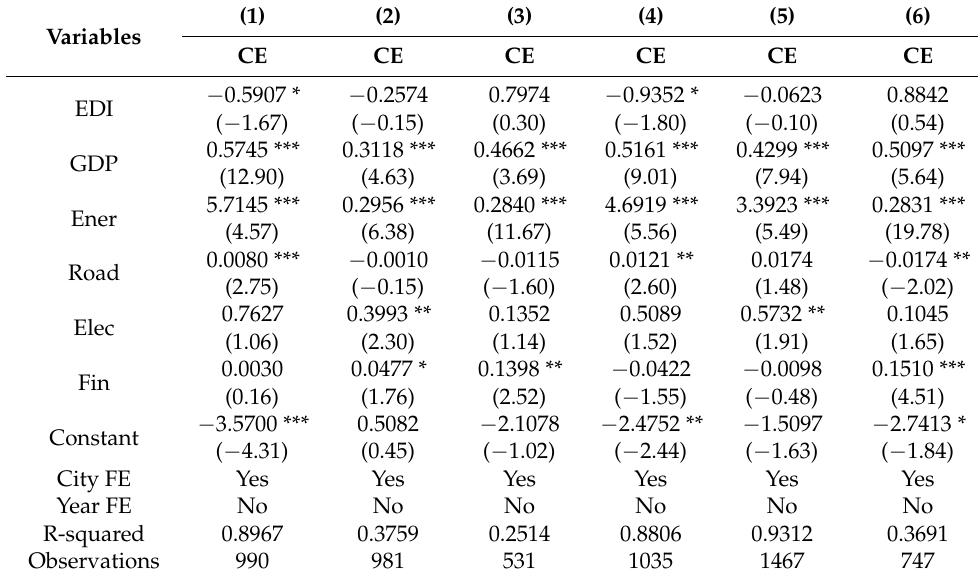
Table 5. Heterogeneity impact